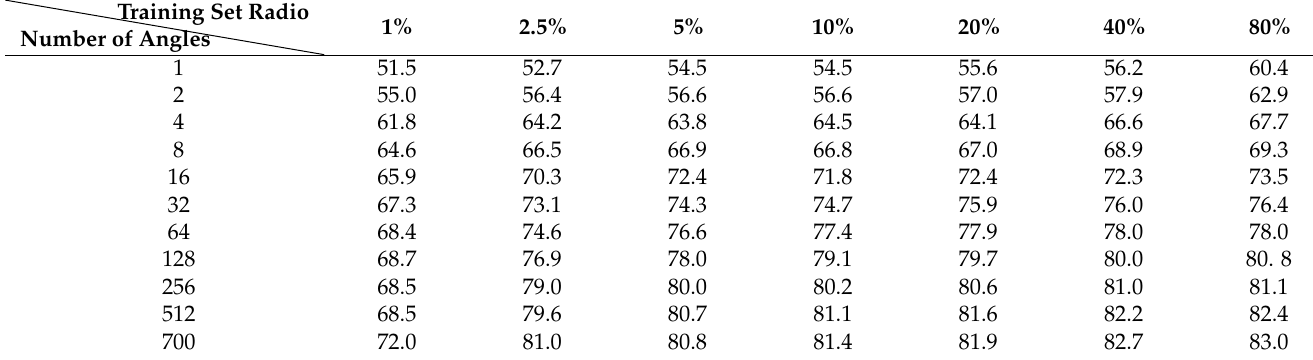
Table 3. Classification OAs derived using the ensemble learning